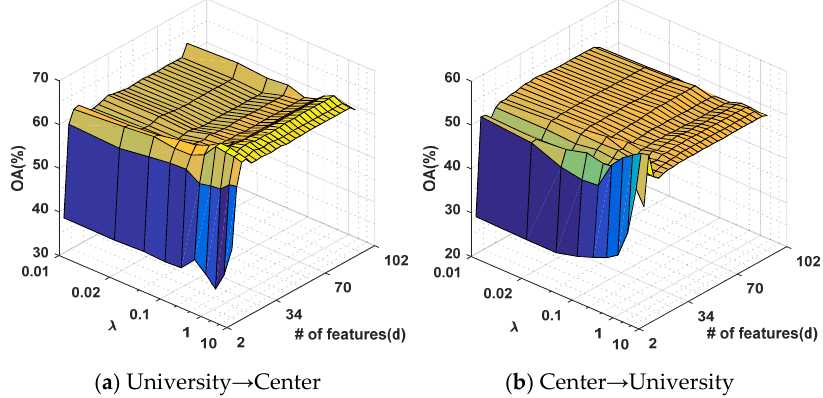
Figure 8. Cont. Figure 8. Cont.